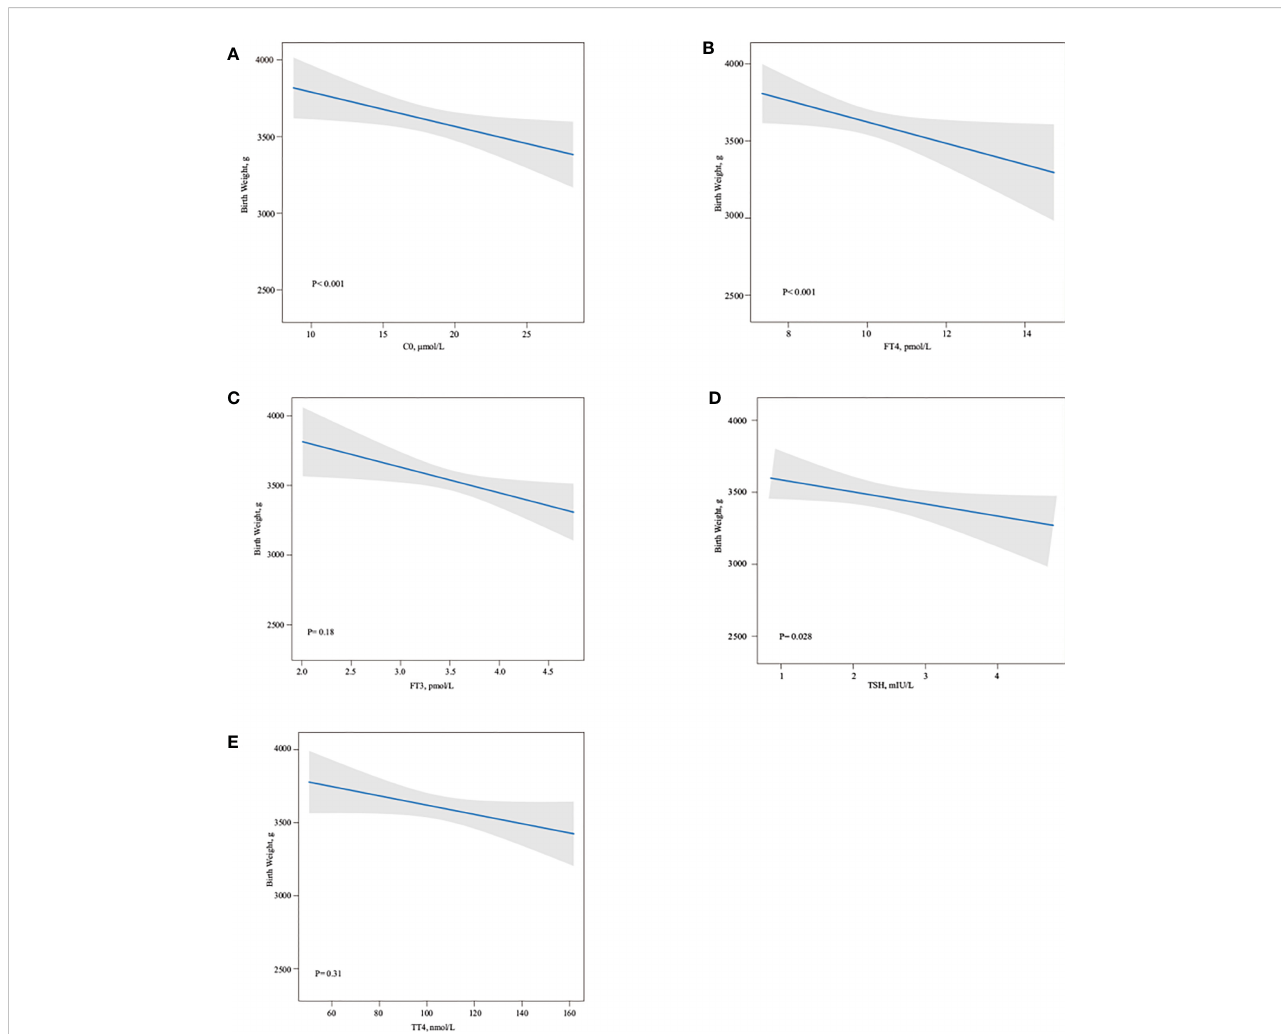
FIGURE 3 Association of maternal free carnitine and thyroid hormones in the second trimester pregnancy and neonate birth weight. Linear regression models for C0 (A) , FT4 (B) , FT3 (C) , TSH (D) , TT4 (E) with birth weight, as predicted mean with 95% CI, were shown above. C0, FT4, and TSH negatively in fl uenced neonate birth weight (all P < 0.05), whereas there were no statistically association between FT3 and TT4 and neonate birth weight. Analyses were adjusted for maternal age, BMI, parity, and fetal